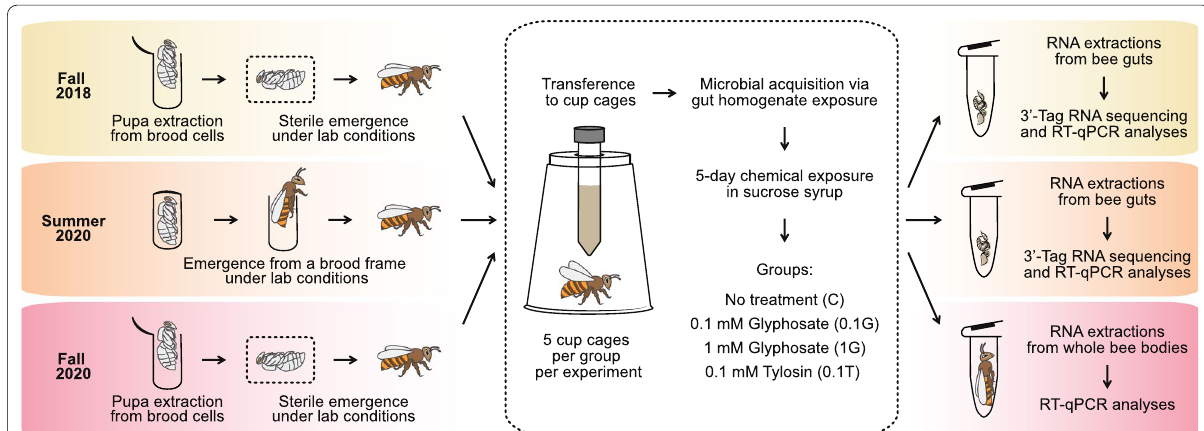
Fig. 1 In vivo experiments to investigate the effects of glyphosate and tylosin on the honey bee immune system. Three independent experiments were performed with newly emerged honey bees ( Apis mellifera ) originating from different hives from different seasons. In the fall 2018 and fall 2020 experiments, pupae were extracted from a brood frame and allowed to emerge under sterile conditions, whereas in the summer 2020 experiment, pupae were allowed to emerge naturally from a brood frame kept in the laboratory. In all experiments, healthy newly emerged workers were transferred to cup cages and allowed to acquire their microbiota simultaneously to treatment (0.1 mM glyphosate, 1 mM glyphosate or 0.1 mM tylosin in sucrose syrup) for 5 days. A control group was treated with sucrose syrup only. In the fall 2018 and summer 2020 experiments, RNA was extracted from individual bee guts and pooled for 3 ′ -Tag RNA sequencing (3 pooled guts per sample, 5 samples sequenced per group), whereas in the fall 2020 experiment, RNA was extracted from whole bee bodies (15 individual bees per group) and used in downstream